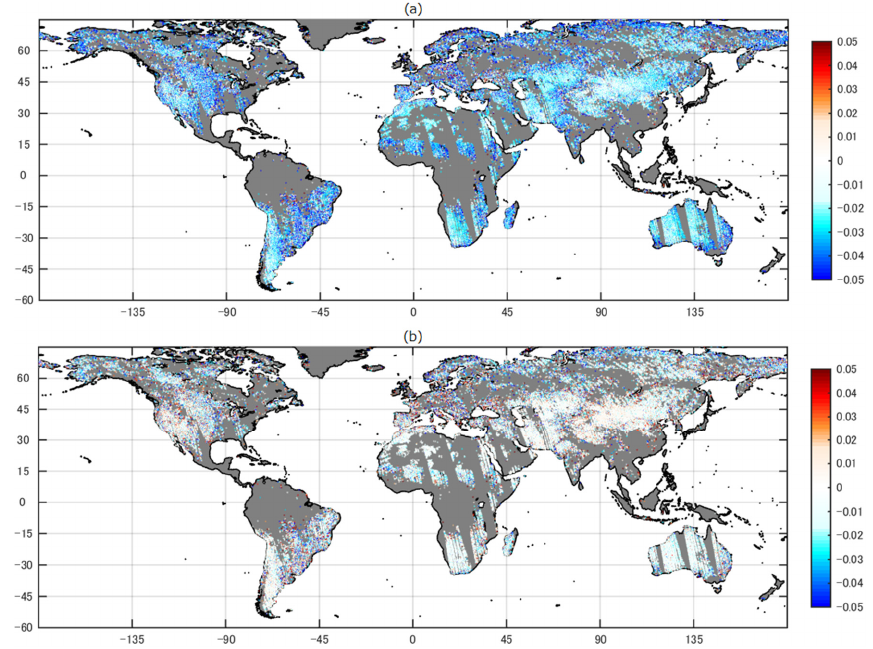
Figure 6. ( a ) Spatial distribution of MODIS EVI minus VIIRS EVI ( δ (cid:2869) ) over geographic coordinate for the evaluation; ( b ) Spatial distribution of MODIS EVI minus MODIS-compatible EVI ( δ (cid:2870) ∗ ).